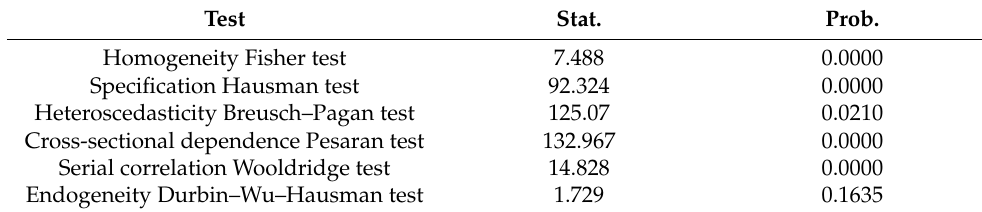
Table 3. Results of the analysis selection